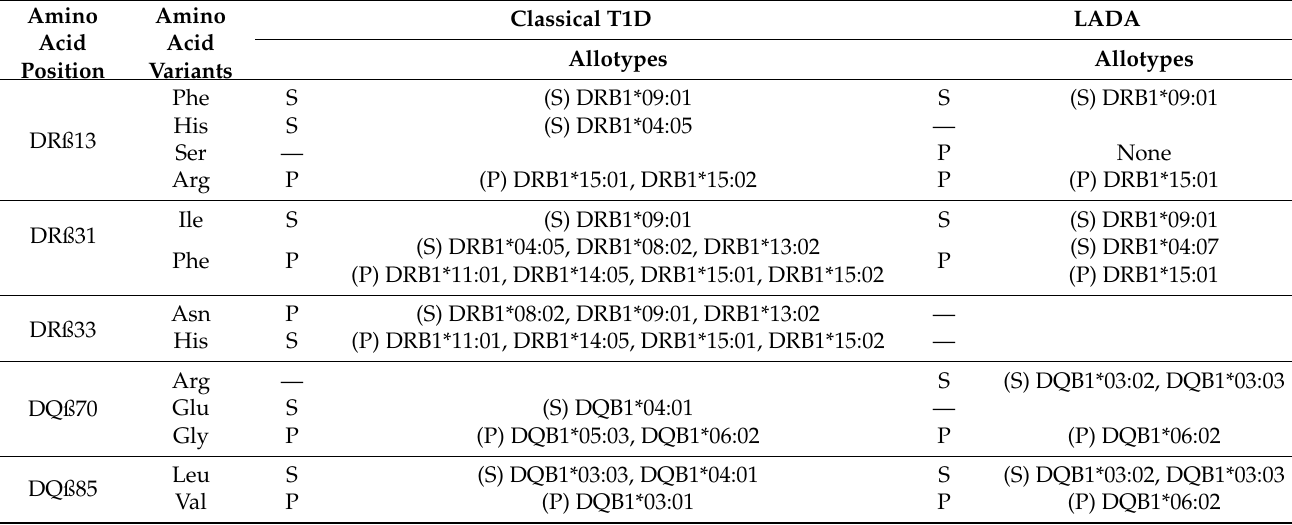
Table 3. HLA-DRB1 amino acid variants at positions 13, 31, and 33, and HLA-DQB1 amino acid variants at positions 70 and 85, which confer susceptibility to or protection against classical T1D or